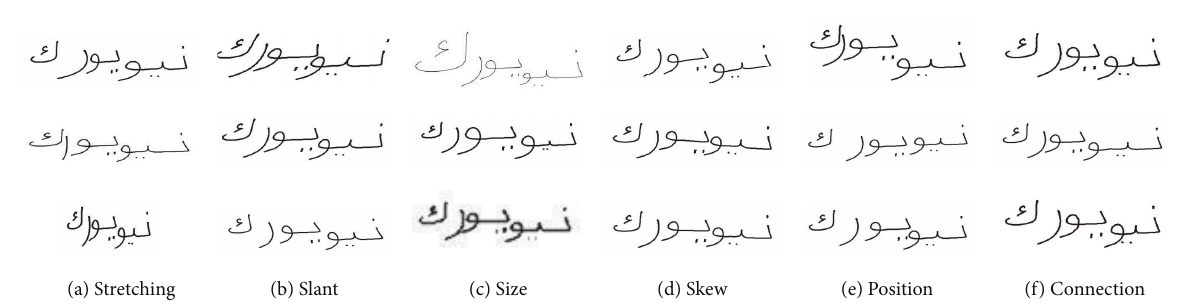
Figure 7: Affine transformations and connection shortening on synthetic